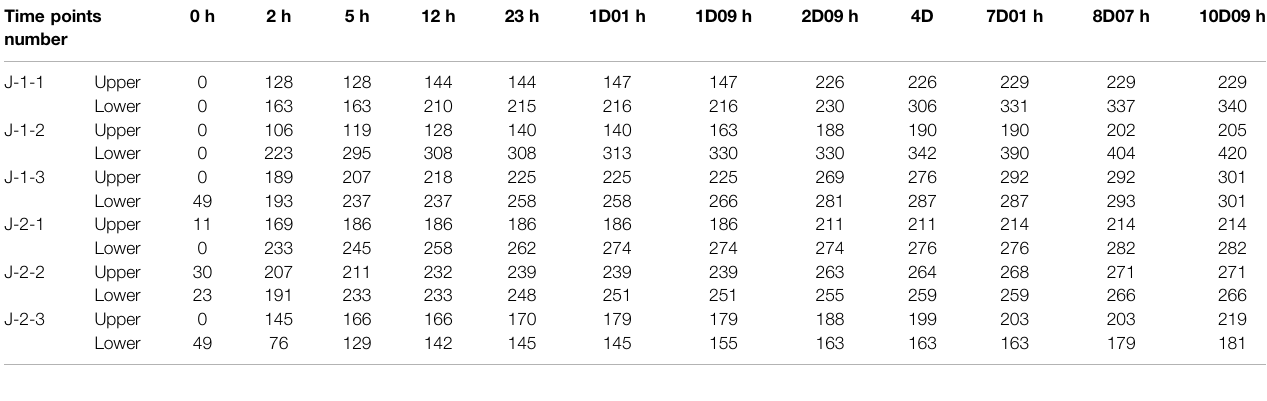
TABLE 3 | Statistics of length of all hydration crack of specimens soaking in distilled water and fracturing fl uid (Unit: mm).